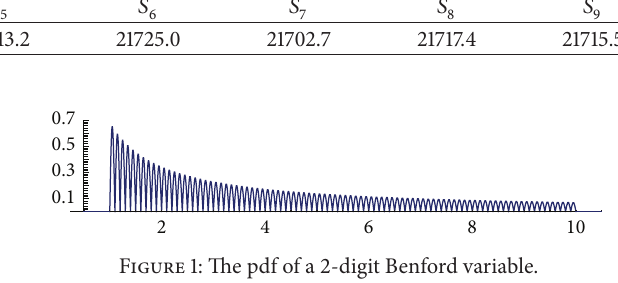
Figure 1: The pdf of a 2 -digit Benford